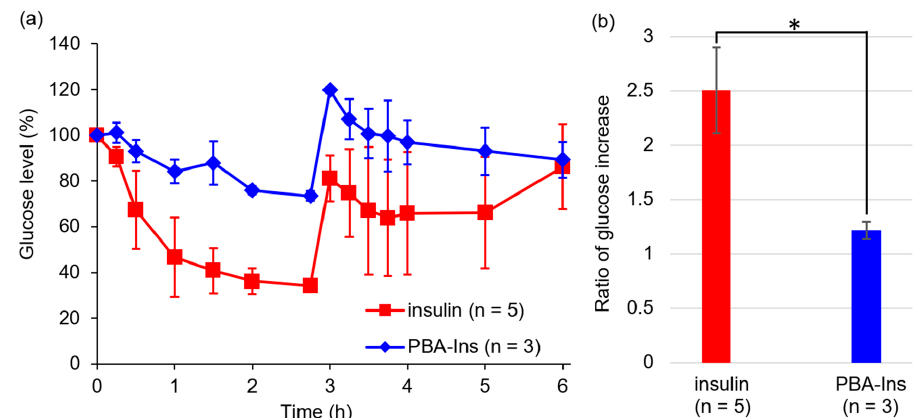
Figure 8. The effect of abdominal injection of glucose (1.00 g/kg) at 2.75 h after the subcutaneous Figure 8. The e ff ect of abdominal injection of glucose (1.00 g / kg) at 2.75 h after the subcutaneous injection of insulin or PBA-Ins (190 µg/kg). ( a ) Profile of blood glucose level. Each value presents mean injection of insulin or PBA-Ins (190 µ g / kg). ( a ) Profile of blood glucose level. Each value presents mean ± S.D. ( n = 5 or 3). ( b ) The ratio of glucose increase calculated by dividing glucose level (6 h) by glucose level (2.75 h). * means p < 0.05 calculated using Student’s t